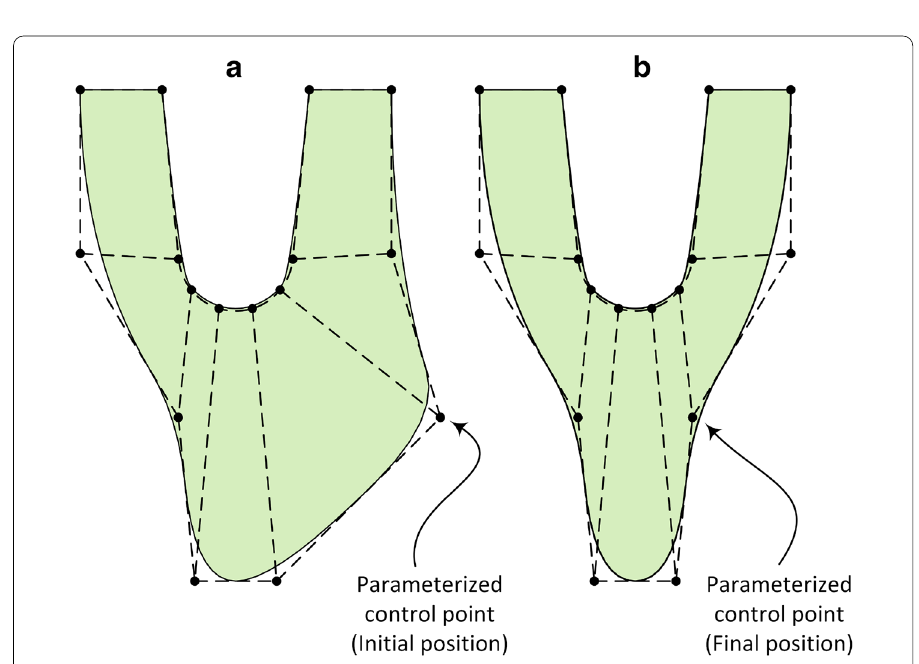
Fig. 22 Geometry parameterization of a complex Y shaped domain: extreme positions of the moving control point